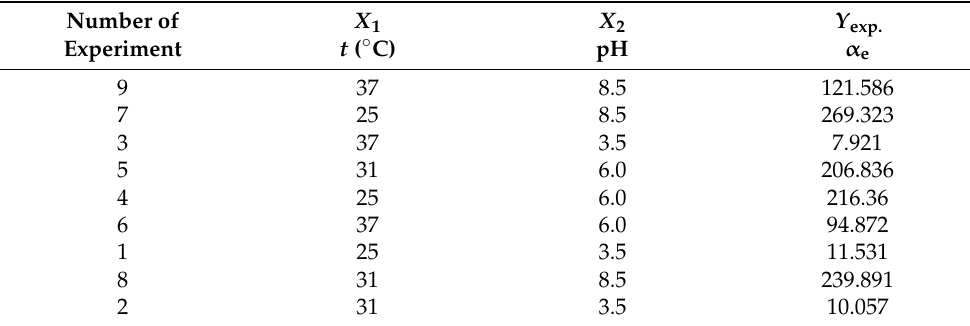
Table 4. Matrix of the full factorial design with experimental values of the responses. Number of